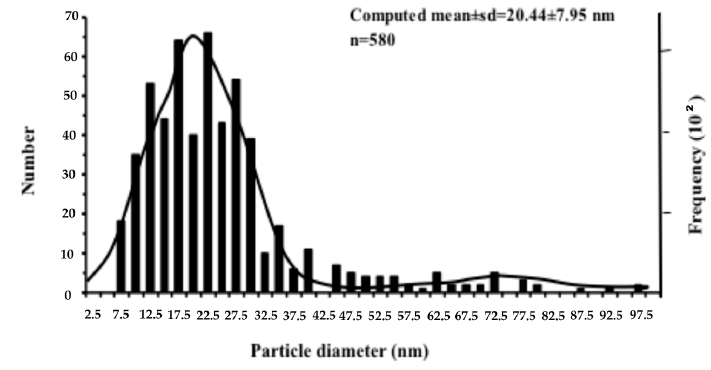
Figure 2. Distribution pattern of ZnO NPs from TEM